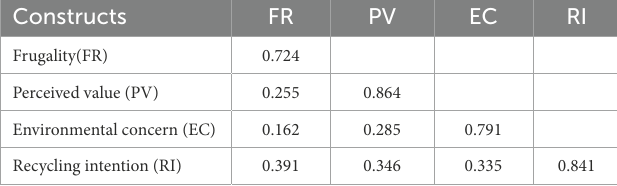
TABLE 2 Results of measurement model analysis. Construct